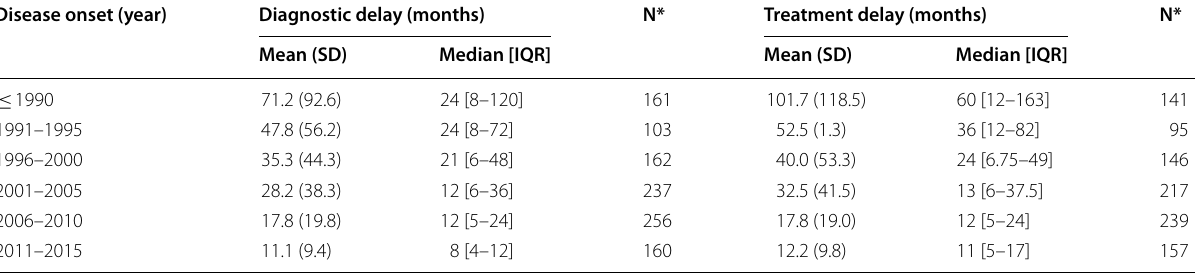
RA, rheumatoid arthritis; SD, standard deviation; IQR, interquartile range *Numbers of participants with data available for the assessments